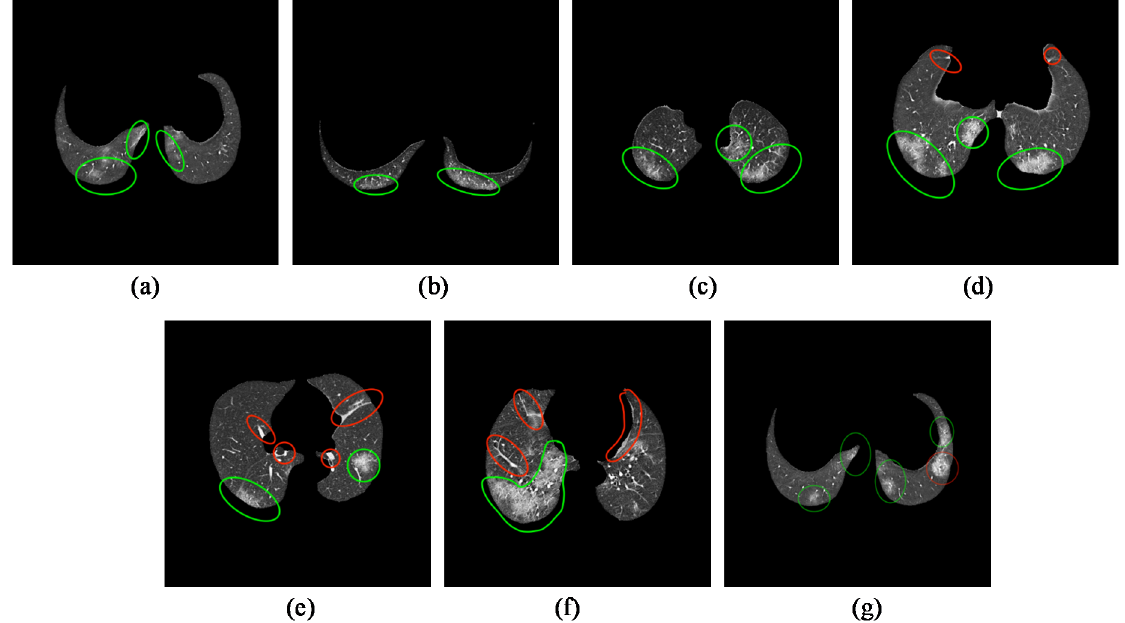
Figure 13. ( a – g ) Samples of synthetic COVID-19 CT images examined by an experienced radiologist. The green annotations indicate findings of GGO, whereas red annotations indicate irrelevant features of GGO.